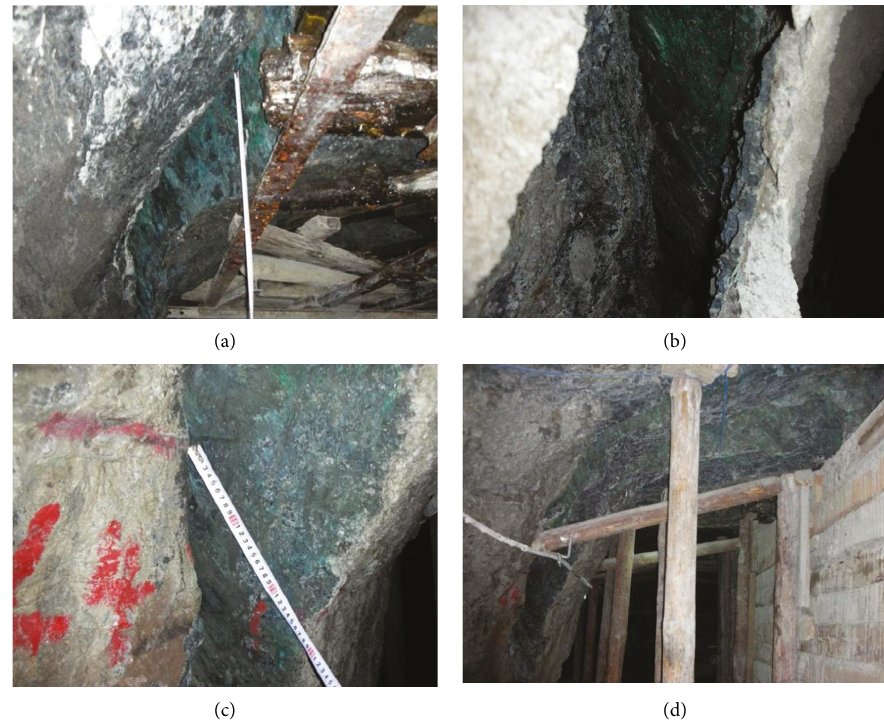
Figure 3: Photograph of partial slip on fault F2: (a) the displacement of the main roadway along the fault in sublevel 12, (b) dislocations along the faults of the ore slip bypass in sublevel 12, (c) the slip of the fault near the pass in sublevel 12, and (d) fault dislocation of material chamber in sublevel